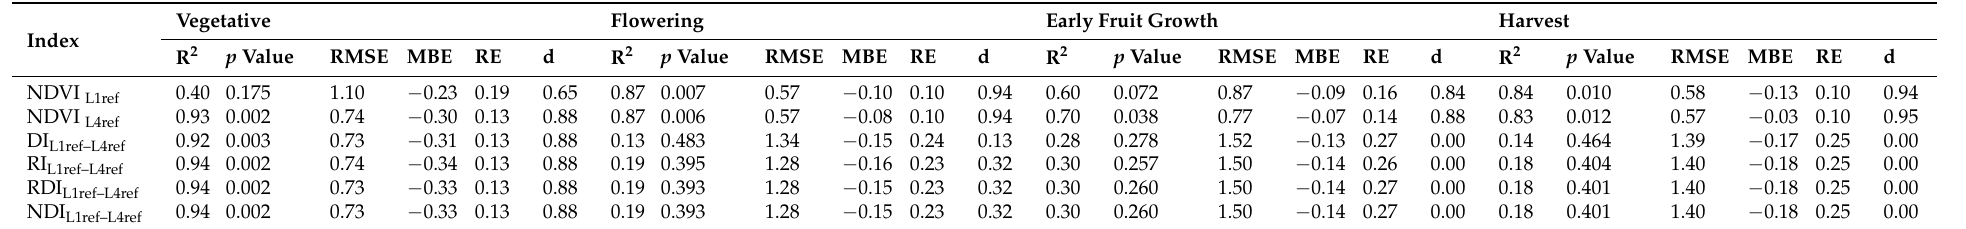
Table 9. Results of the validation analysis of the estimated fruit yield (kg m − 2 ) from NDVI measurements and several normalized NDVI indices (DI, RI, RDI, NDI), at different phenological stages of sweet pepper. DI, Difference Index; RI, Relative Index; RDI, Relative Difference Index; NDI, Normalized Difference Index, R 2 , coefficient of determination; RMSE, root mean square error; RE, relative error; MBE, mean bias error; d, Willmott Index. L1ref and L4ref, refer to the latest (most recent) and fourth fully expanded leaf, respectively.